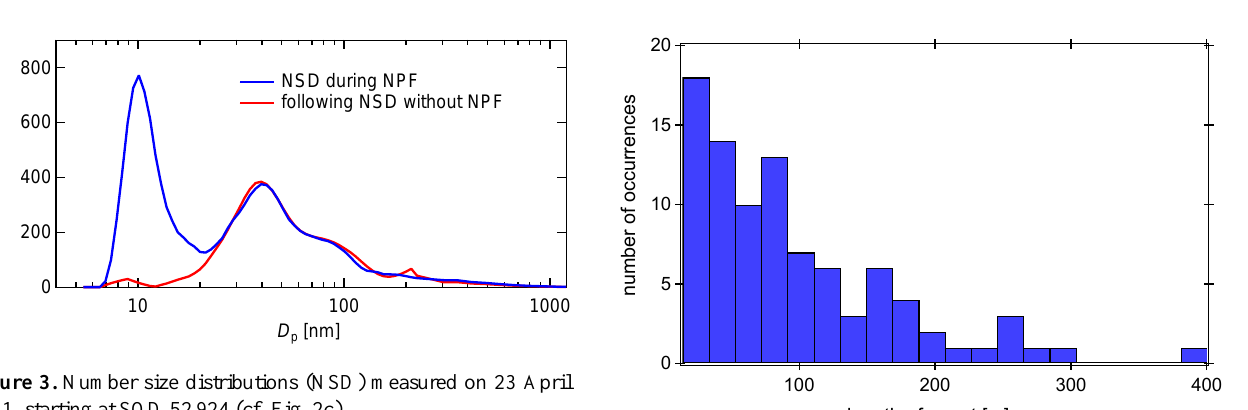
Figure 2. Time series of N CPC , N FCPC , and LWC over 40s each during an event of increased particle number concentration (a) at a cloud edge, (b) between clouds, (c) in the entrainment region, and (d) without clouds nearby.